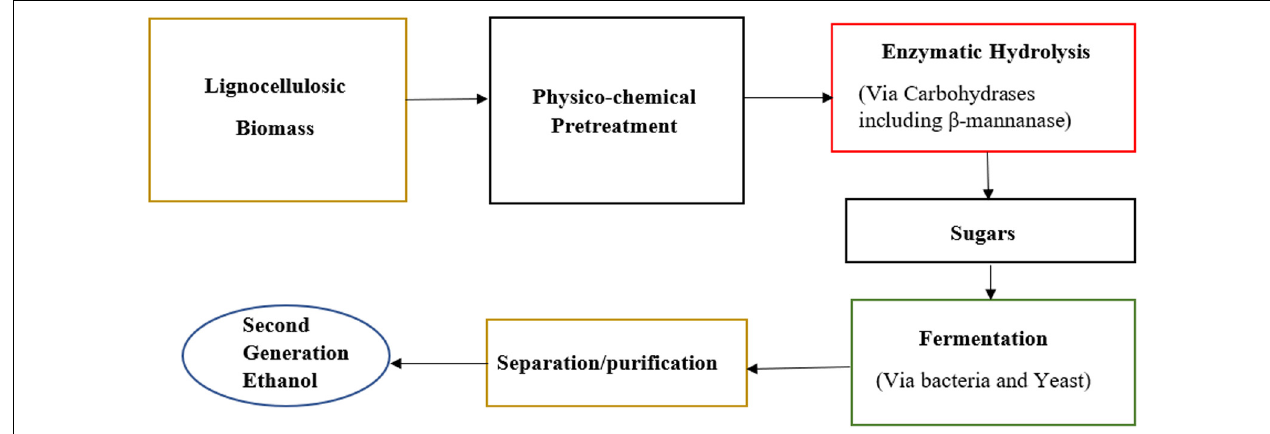
FIGURE 5 | Overview of bioethanol production from lignocellulosic biomass based on β -mannanase hydrolysis.